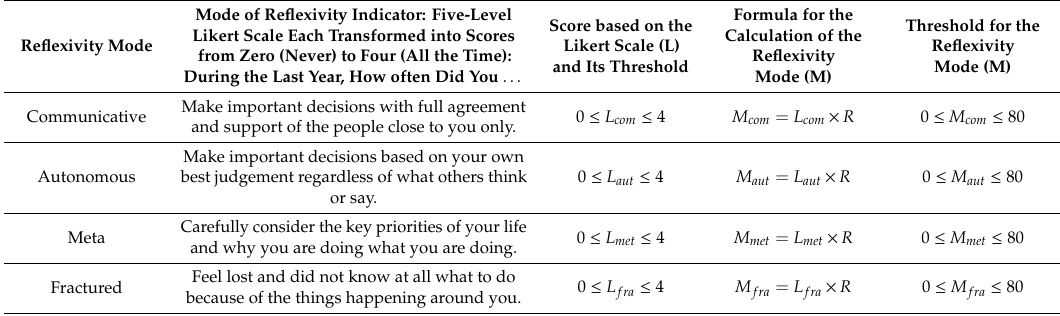
Table 1. Statements indicating di ff erent reflexivity modes and the formulas for their calculation 1 .